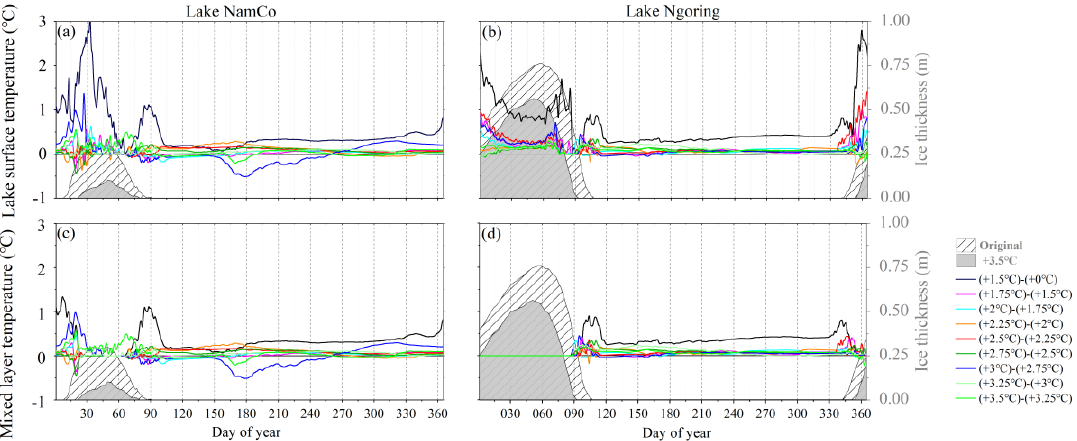
Figure 8. Seasonal variations in the lake ice thickness (shading), and the difference between LST and MLT sensitivities to different temperature increases (lines), averaged from January 2012 to December 2016 ( a,c ) at Lake Nam Co and ( b,d ) at Lake Ngoring. The details of the legend are the same as in Figure 7.